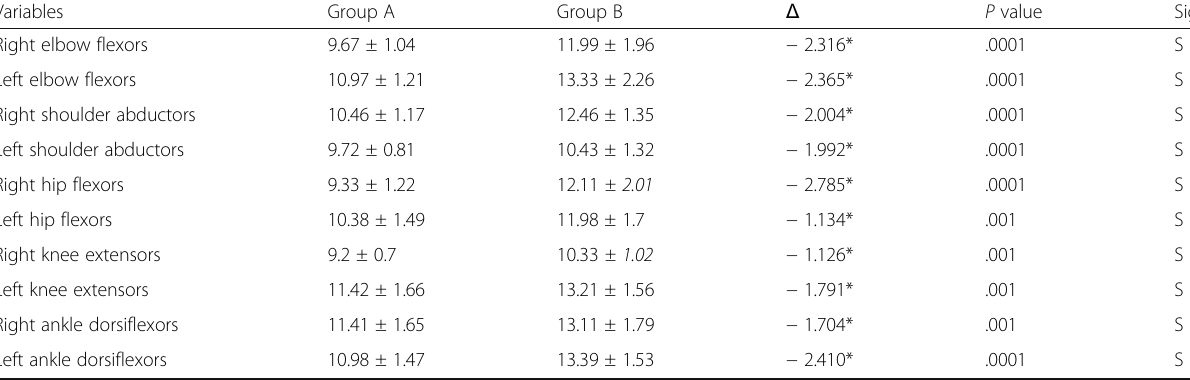
Table 6 Comparison of mean values of muscle strength after treatment among groups A and B Variables Group A Right elbow flexors Right shoulder